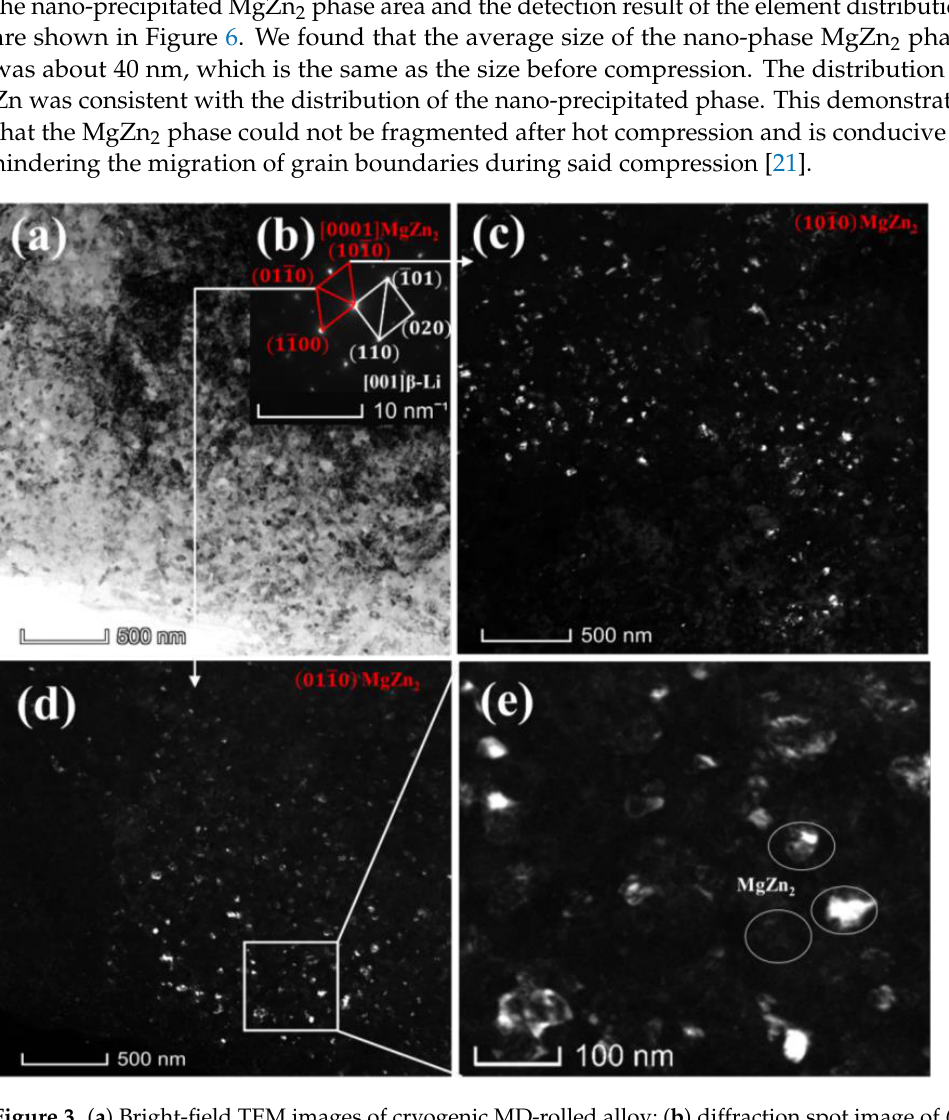
Figure 3. ( a ) Bright-field TEM images of cryogenic MD-rolled alloy; ( b ) diffraction spot image of ( a ); ( c – e ) dark-field TEM images of nano-MgZn 2 phases.